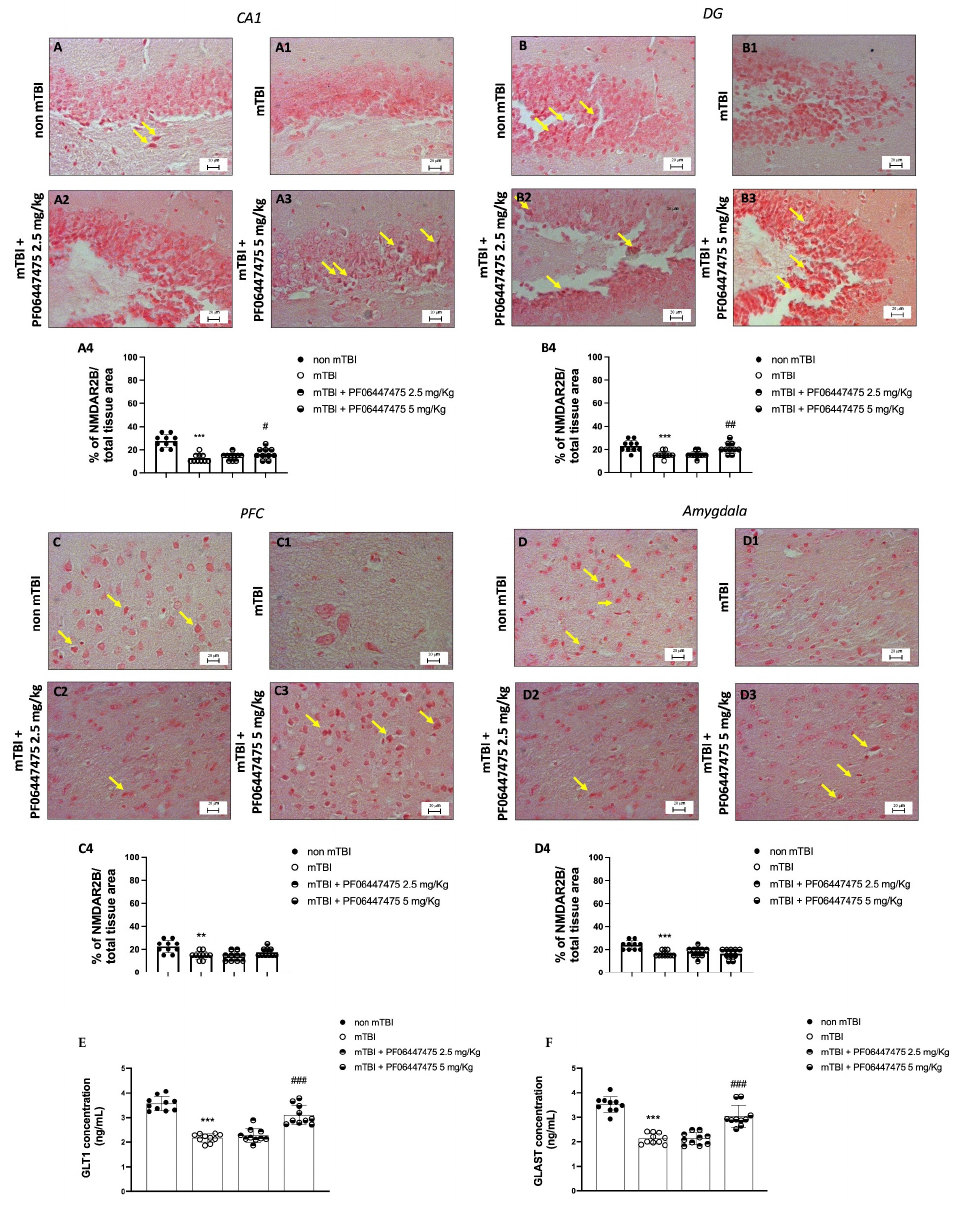
Figure 3. Immunohistochemical localization of NMDAR2B after mTBI in CA1, DG, PFC and amygdala areas. CA1 area: the non-mTBI group ( A ) and the mTBI group ( A1 ), see percentage of NMDAR2B over the total tissue area ( A4 ). PF-475 2.5 mg/kg ( A2 ) and 5 mg/kg ( A3 ), see percentage of NMDAR2B over the total tissue area ( A4 ). DG area: the non-mTBI group ( B ) and the mTBI group ( B1 ), see percentage of NMDAR2B over the total tissue area ( B4 ). PF-475 2.5 mg/kg ( B2 ) and 5 mg/kg ( B3 ), see percentage of NMDAR2B over the total tissue area ( B4 ). PFC area: the non-mTBI group ( C ) and the mTBI group ( C1 ), see percentage of NMDAR2B over the total tissue area ( C4 ). PF-475 2.5 mg/kg ( C2 ) and 5 mg/kg ( C3 ), see percentage of NMDAR2B over the total tissue area ( C4 ). Amygdala area: the non-mTBI group ( D ) and the mTBI group ( D1 ), see percentage of NMDAR2B over the total tissue area ( D4 ). PF-475 2.5 mg/kg ( D2 ) and 5 mg/kg ( D3 ), percentage of NMDAR2B over the total tissue area ( D4 ). The concentrations of GLT1 and GLAST in brain tissues ( E , F ). Data are expressed as SD from 10 mice for each group. Two-way ANOVA test. ** p < 0.01 and *** p < 0.001 vs. non mTBI; # p < 0.05, ## p < 0.01 and ### p < 0.001 vs.